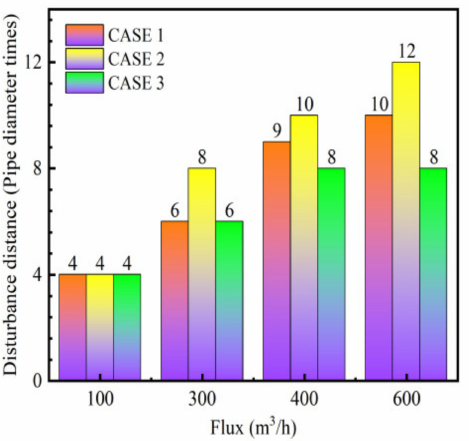
Figure 5. Relationship between disturbance distance and flow rate for different